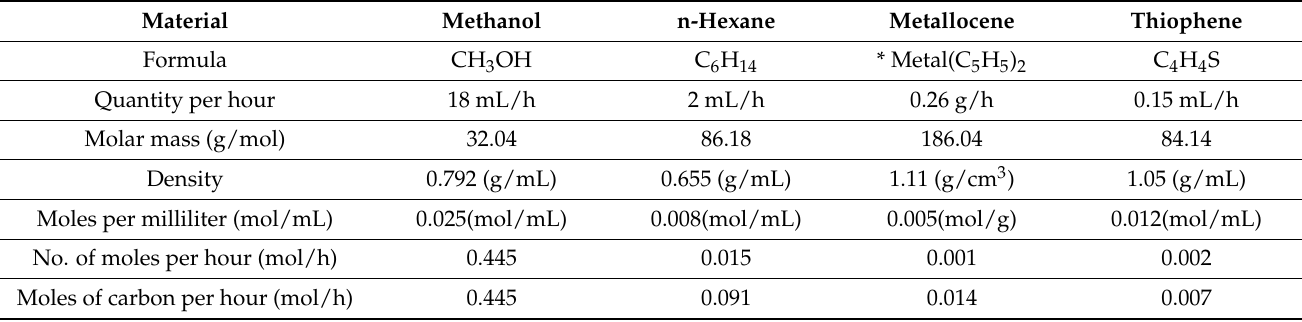
Table A1. Calculation of carbon supplied per